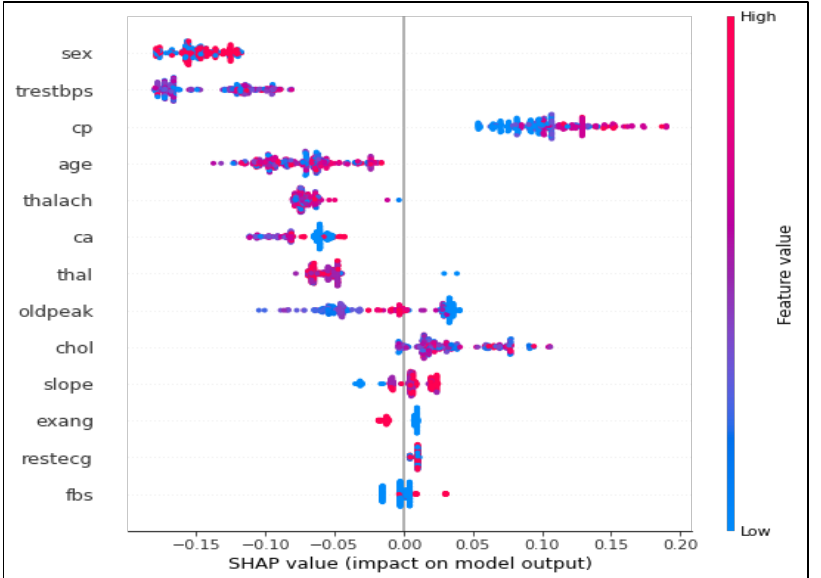
Figure 8. Summary plot of the SHAP values.